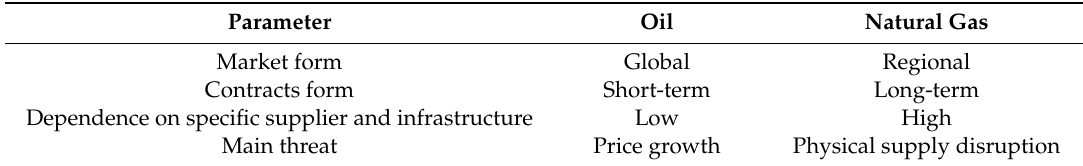
Table 1. Di ff erences in the oil and natural gas market